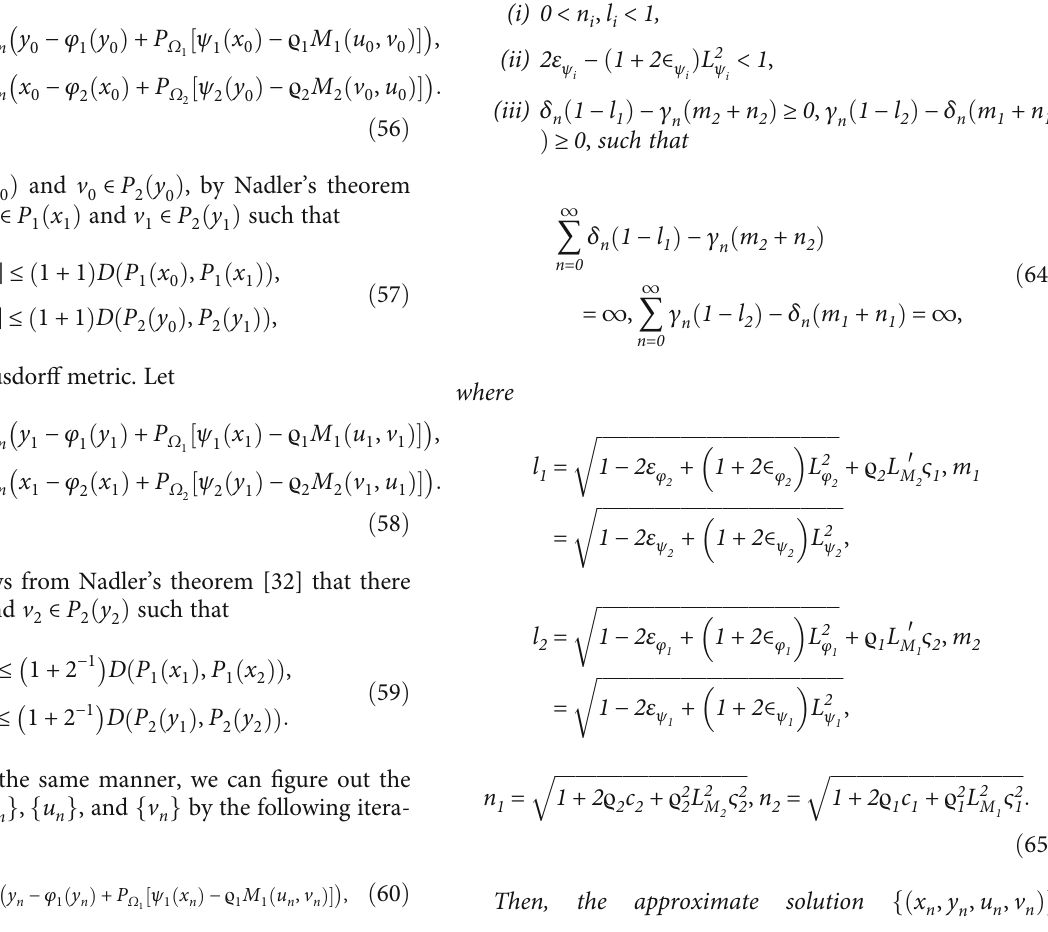
∈ P 2 ð y 0 Þ . For